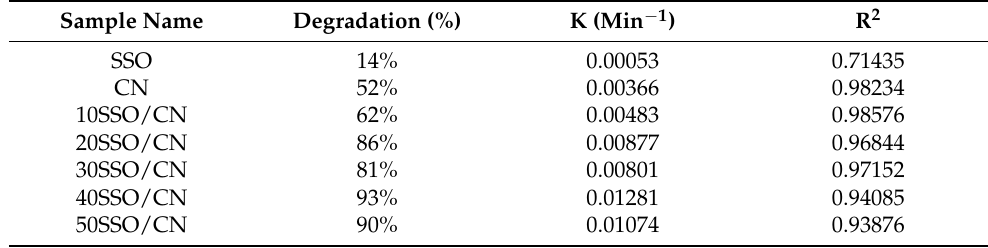
Table 2. Comparison with other g-C 3 N 4 based heterojunction photocatalyst in CIP